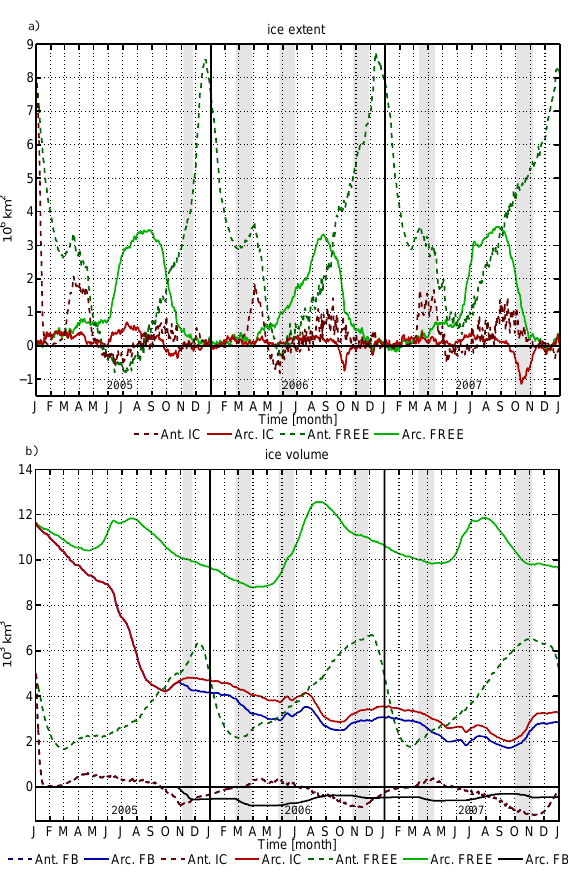
Fig. 3. Times series of sea-ice extent over 2005–2007 (a) . The ob- servations are in black. The red lines correspond to the IC run and the green lines to the FREE run. The dashed lines are for the NH and the solid lines for the SH. (b) Differences between model and observations are plotted with the same codes. Grey shading areas indicate periods when the ice freeboard data are available. A one week smoothing is apply on both